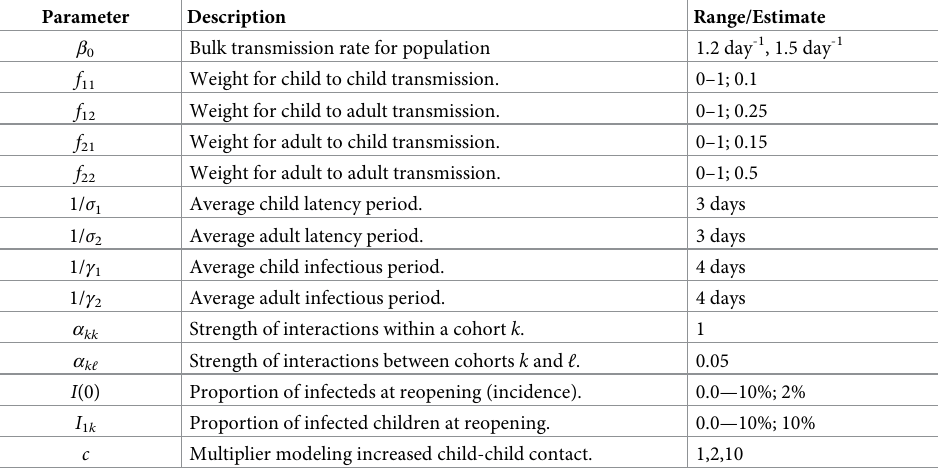
Table 1. Summary of model parameters with ranges and estimates. Parameter